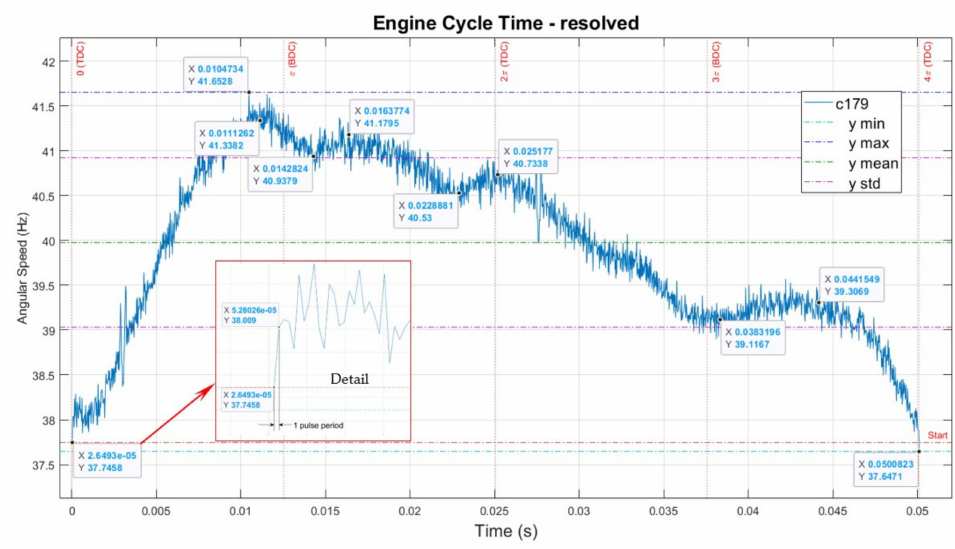
Figure 16. Engine typical cycle signature—time scale.